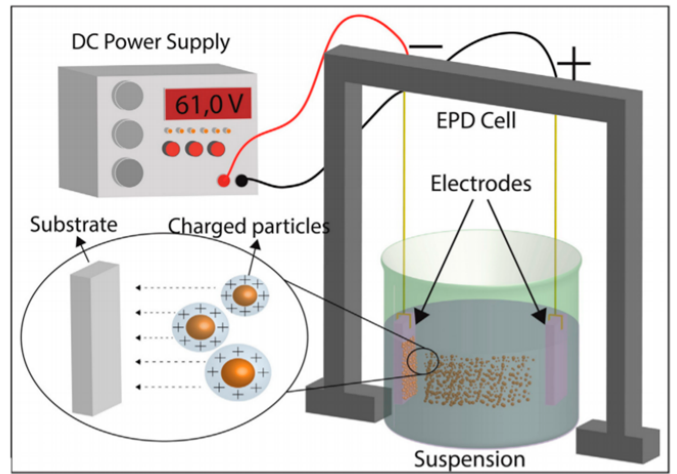
Figure 8. Schematic illustration of an EPD cell. Reprinted from Reference [82] with permission from